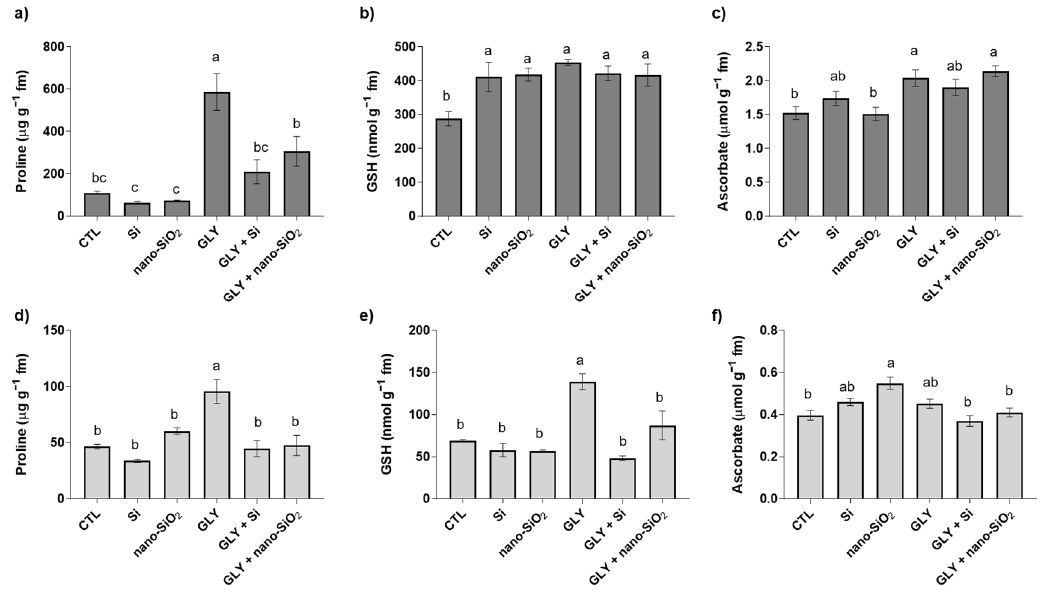
Figure 5. Levels of the main antioxidant metabolites of S. lycopersicum plants after 4 weeks of growth. ( a , d ) proline (Pro); ( b , e ) glutathione (GSH); ( c , f ) total ascorbate. Dark and light bars represent shoots and roots, respectively. Data presented are mean ± STDEV ( n ≥ 3). Different letters (a–c) above bars indicate significant statistical differences between treatments (Tukey: p ≤ 0.05).